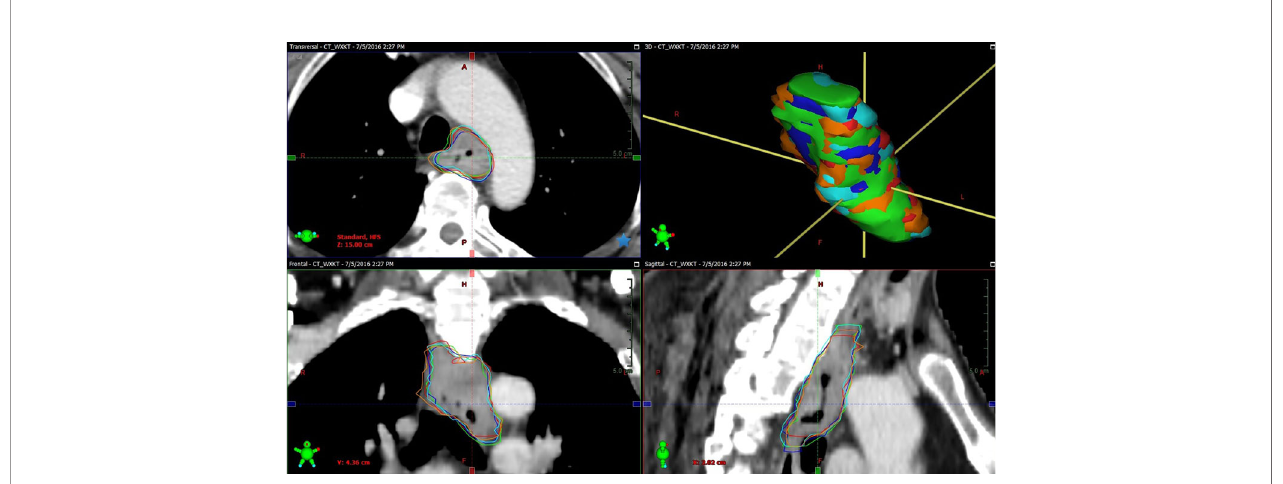
FIGURE 2 | Example of GTVs delineated based on CT combined with endoscopy/EUS, esophagogram, and FDG-PET/CT (GTV CEXP ) by observer 1 (green segment), observer 2 (red segment), observer 3 (blue segment), observer 4 (orange segment), and observer 5 (cyan segment) in tansversal, frontal, surface, and sagittal planes for one patient (Patient 10). The volume and longitudinal length of GTV CEXP delineated on CT combined with endoscopy/EUS, esophagogram, and FDG-PET/CT exhibiting a good